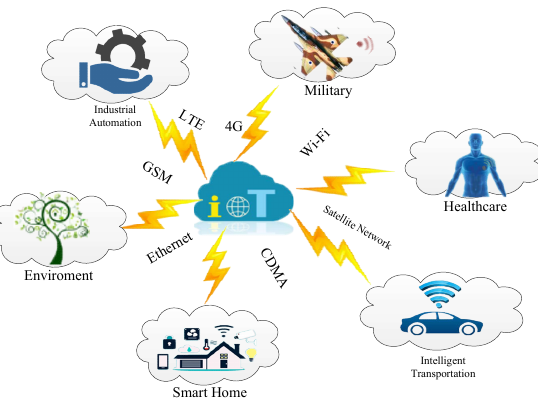
Figure 1. Internet of Things (IoT)